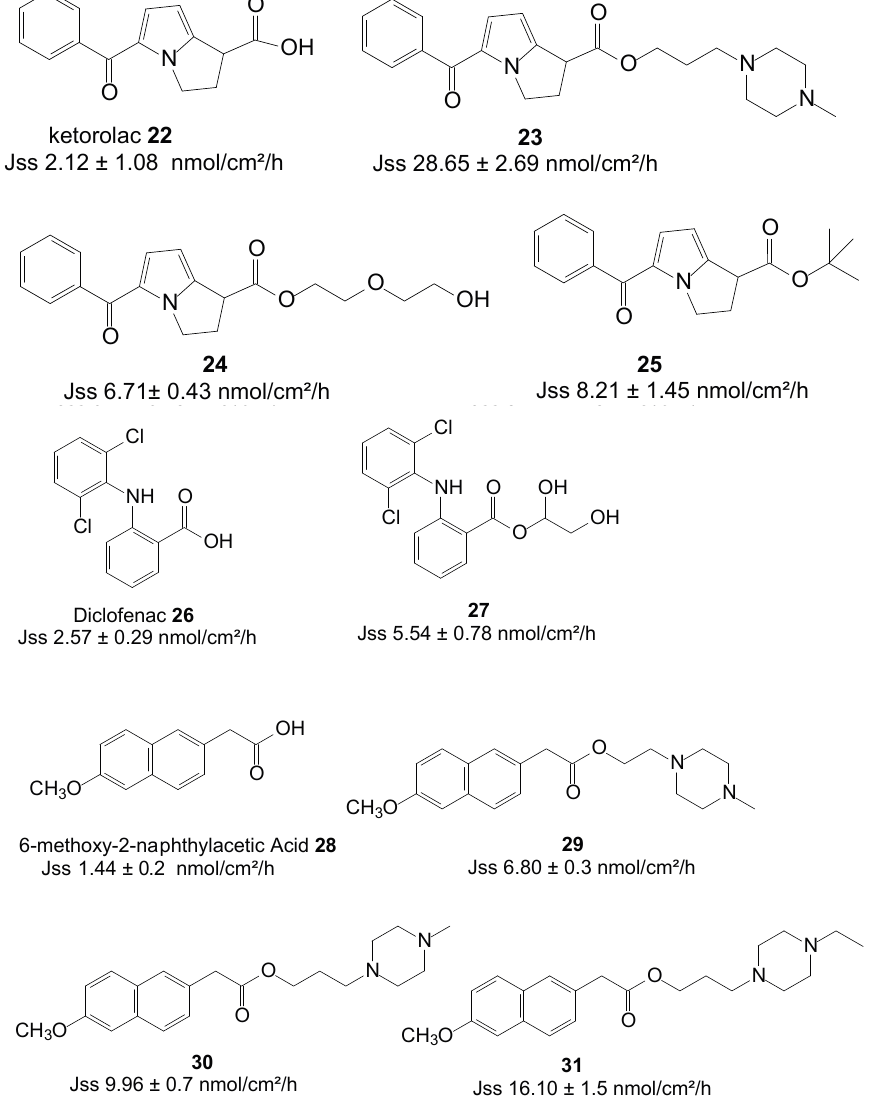
Figure 7. Structures of NSAIDs and their best permeant ester